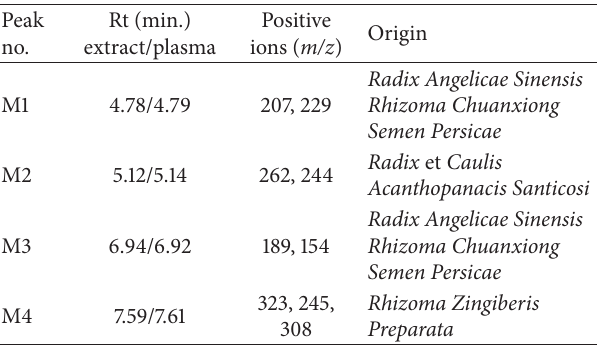
Table 3: The retention times, +ESI-MS/MS data ( 𝑚/𝑧 ), and origins of the metabolites in rat serum after oral administration of WJSH